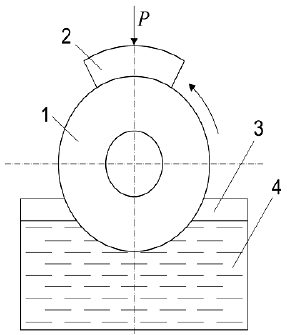
Figure 1. Schematic diagram of the friction tests: 1 —rotating specimen in the form of a disk from the D16T or AMg16 light alloys with plasma electrolytic oxidation (PEO) layers synthesized on their outer cylindrical surface; 2 —blocking segment-like specimen from the 45 or U8 steels; 3 —reservoir with lubricant, 4 —lubricating medium; P —pressing